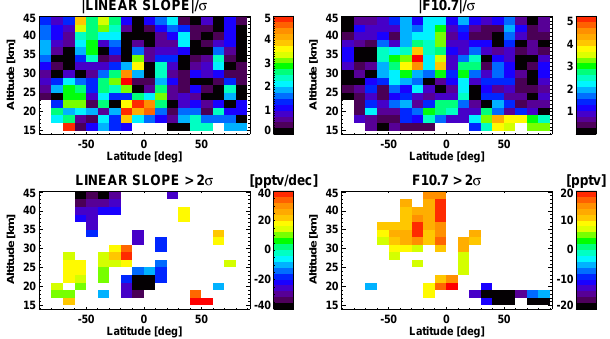
Fig. 16. Top: significance in multiples of the estimated error of the model error corrected linear slope (left) and the F 10 . 7 amplitude (see caption of Fig. 15 for definition) (right). Bottom: remaining values with a significance > 2 σ